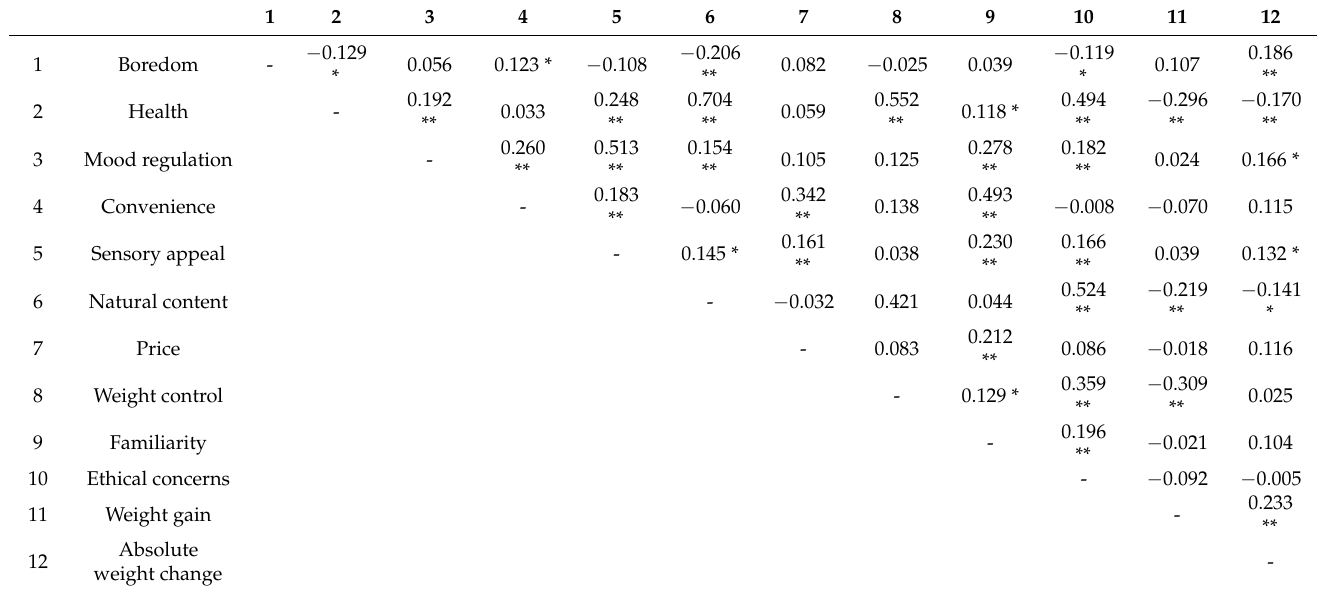
Table 1. Zero-order